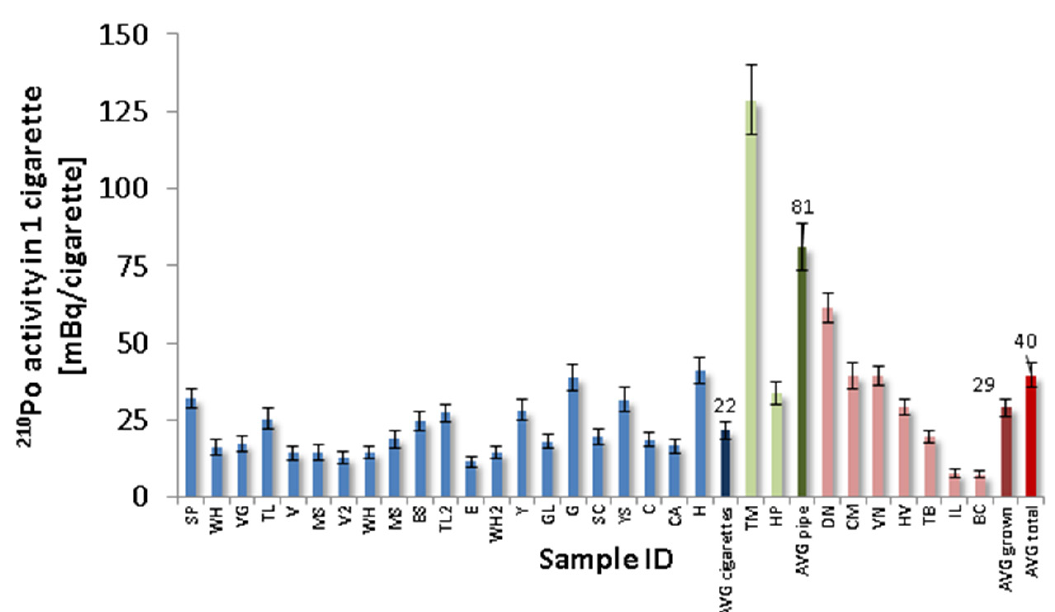
Figure 2. 210 Po activity concentration of the investigated Vietnamese tobacco